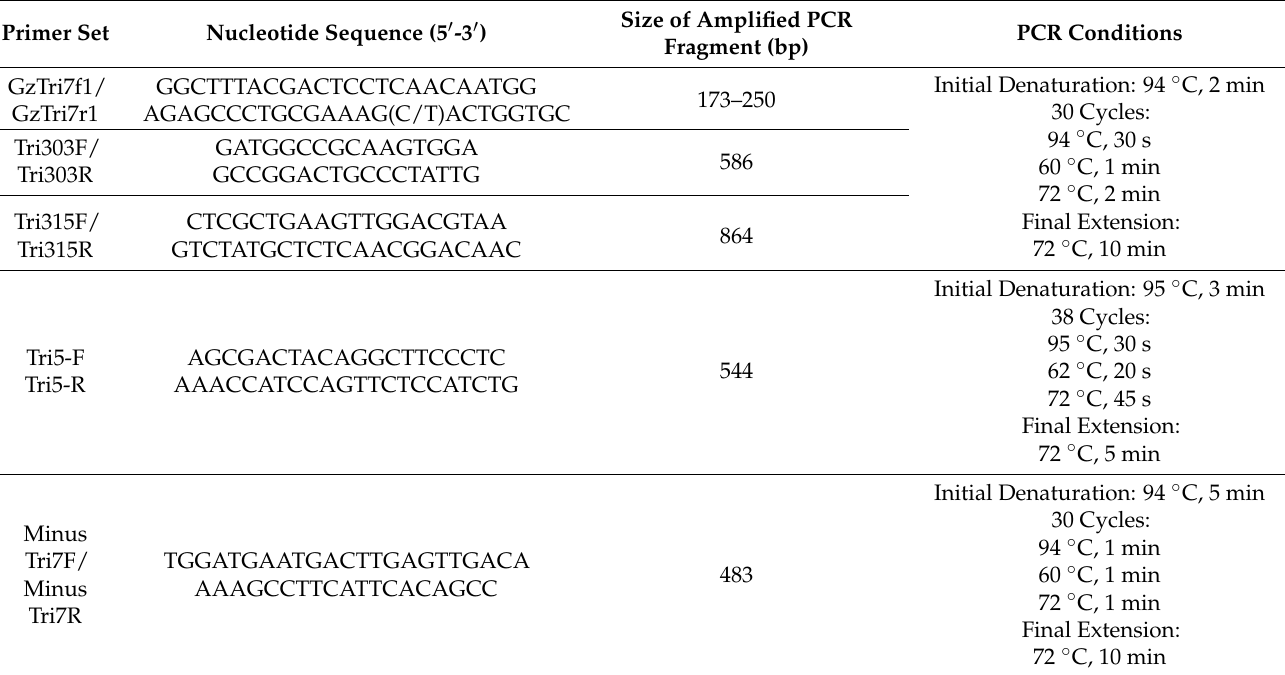
Table 2. Primer sets for multilocus genotyping of F. graminearum